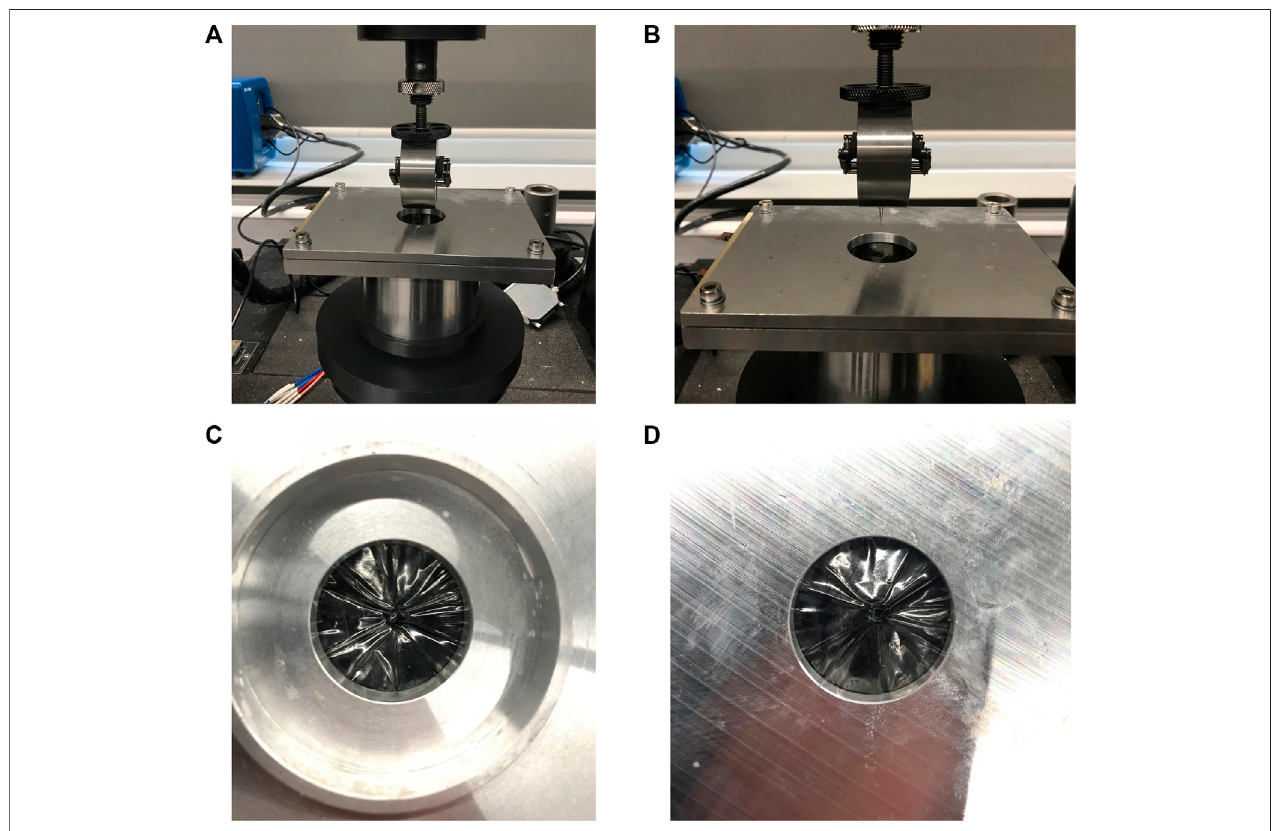
FIGURE 5 | Test setup (A) before and (B) after nail penetration. (C) The penetrated specimen from the top view (D) from the bottom view.